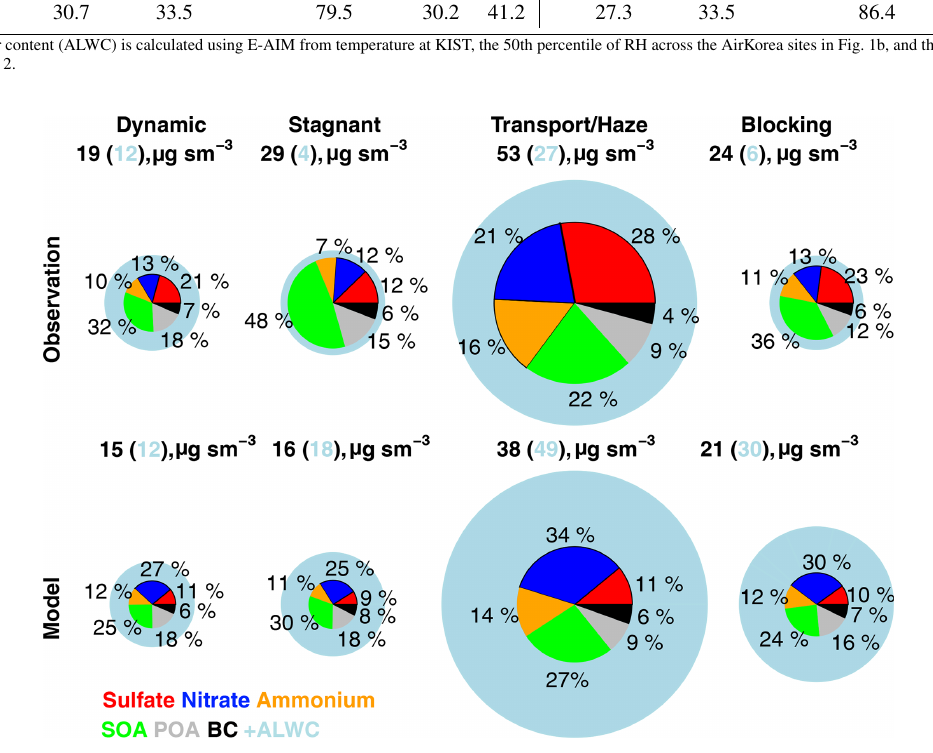
Figure 2. Model simulation of PM 2 . 5 compared against observations wherein the fractional source contributions are calculated from KIST and applied to the mean AirKorea PM 2 . 5 observations from Fig. 1 during the four meteorological periods. Figure values are shown in Table 3. The radius of each pie chart is scaled to the maximum value of modeled or observed PM 2 . 5 (53µgm − 3 ). The blue circles show the aerosol liquid water content (ALWC) associated with PM 2 . 5 . The sulfate–nitrate–ammonium components are bordered in black to guide the